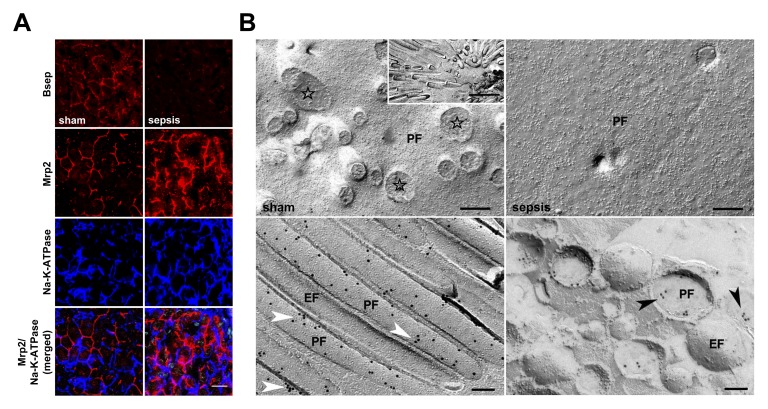
Altered expression of canalicular bile acid and organic anion transporters in sepsis.(A) Distribution and localisation pattern of Bsep and Mrp2 in livers obtained from control and septic rats using confocal microscopy. Na,K-ATPase was used to stain the basolateral plasma membrane. Staining for Bsep revealed a substantial decrease in protein expression after sepsis induction. In sham-treated animals immunoreactive Mrp2 delineates bile canaliculi. The Mrp2 staining pattern in septic rats is irregular, disrupted, and accompanied by recovery of Mrp2 inside the cell, as shown by punctuate staining in the pericanalicular region. Lowermost panels represent merged pictures of Na,K-ATPase and Mrp2. Scale bar: 20 µm. (B) Electron micrographs of freeze-fracture-immunolabelled Mrp2 protein in the plasma membrane of isolated hepatocytes at 15 h post-infection to further study irregular staining observed in sepsis. The cell surface of sham-treated animals is densely covered with microvilli, visible as cross-fractured stubs (stars). A lengthwise fracture of the microvilli membrane exposes a dense labelling with Mrp2 protein arranged in small clusters along microvilli (white arrowheads). By contrast, hepatocytes isolated from septic animals exhibited a loss of microvilli, while Mrp2 was predominantly found in vesicles located closely beneath the canalicular membrane (black arrowheads). The inset shows a top view of a bile canaliculus formed by two adjacent hepatocytes (scale bar: 1 µm). Scale bars in upper and lower panels indicate 200 nm and 100 nm, respectively. EF, exoplasmic fracture face; PF, protoplasmic fracture face.